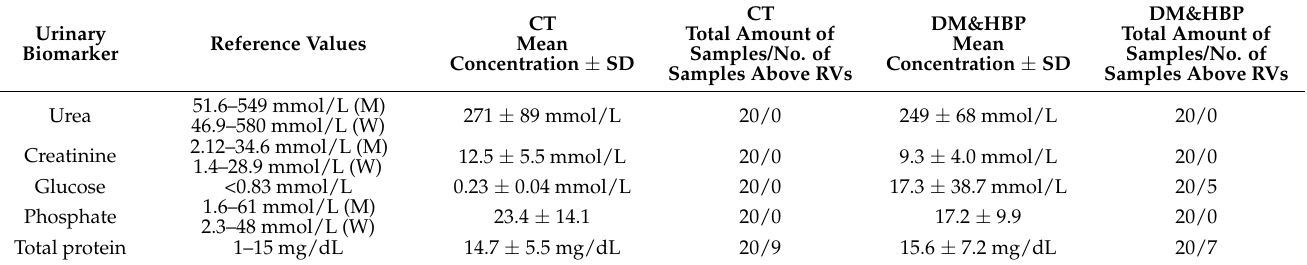
Table 1. Concentration of the main biomarkers of urine from the CT and DM&HBP groups determined using a spectrophotometry assay. Reference values from Wu [34] are converted to SI (mol/L). CT CT Urinary Total Amount of Mean Biomarker Reference Values Samples/No.